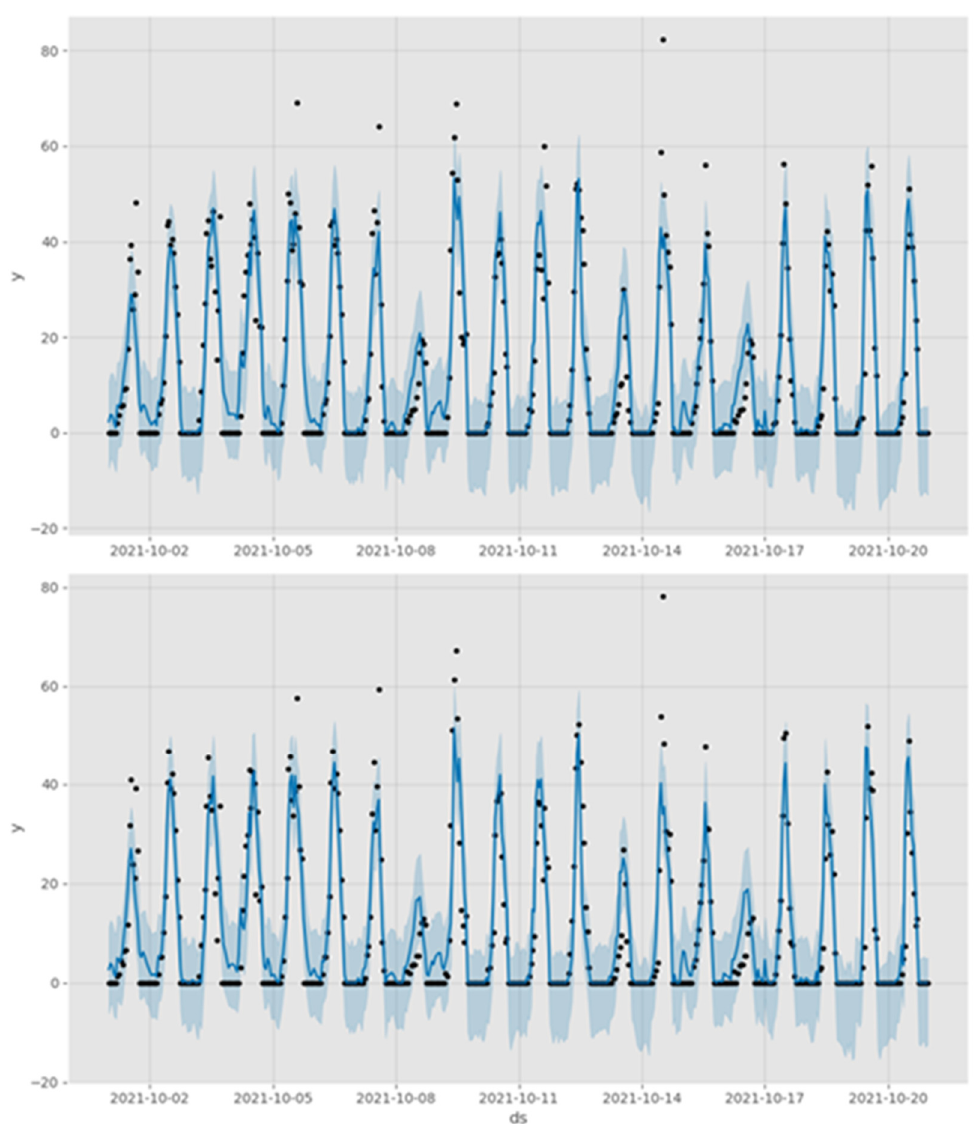
Figure 11. Forecast for the entire (20 days) BEE_OUT and BEE_IN time series.